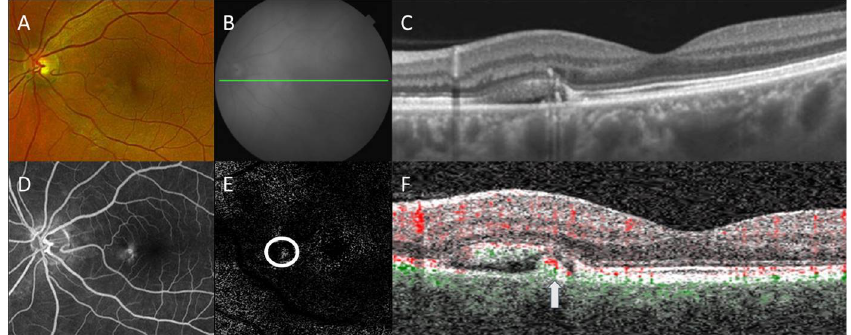
Figure 1. Multimodal imaging of central serous chorioretinopathy with secondary choroidal neovascularization. Color fundus photography ( A ) shows a retinal pigment epithelial (RPE) detachment with surrounding subretinal fluid nasal to the fovea. Corresponding en face near-infrared reflectance ( B ) with B-scan (green line) by swept-source optical coherence tomography (OCT) demonstrates a thickened choroid with overlying pigment adjacent to the subretinal fluid ( C ). Late-phase fluorescein angiography ( D ) revealed corresponding hyperfluorescence without overt indication of choroidal neovascularization. En face OCT angiography (OCTA) with segmentation between the outer retina and RPE ( E ) revealed the focal area of the flow signal (circle), which on B-scan (green: choroidal flow, red: retinal flow) localizes (arrow) within the RPE detachment ( F ), consistent with secondary choroidal neovascularization. Projection artifacts were removed automatically for